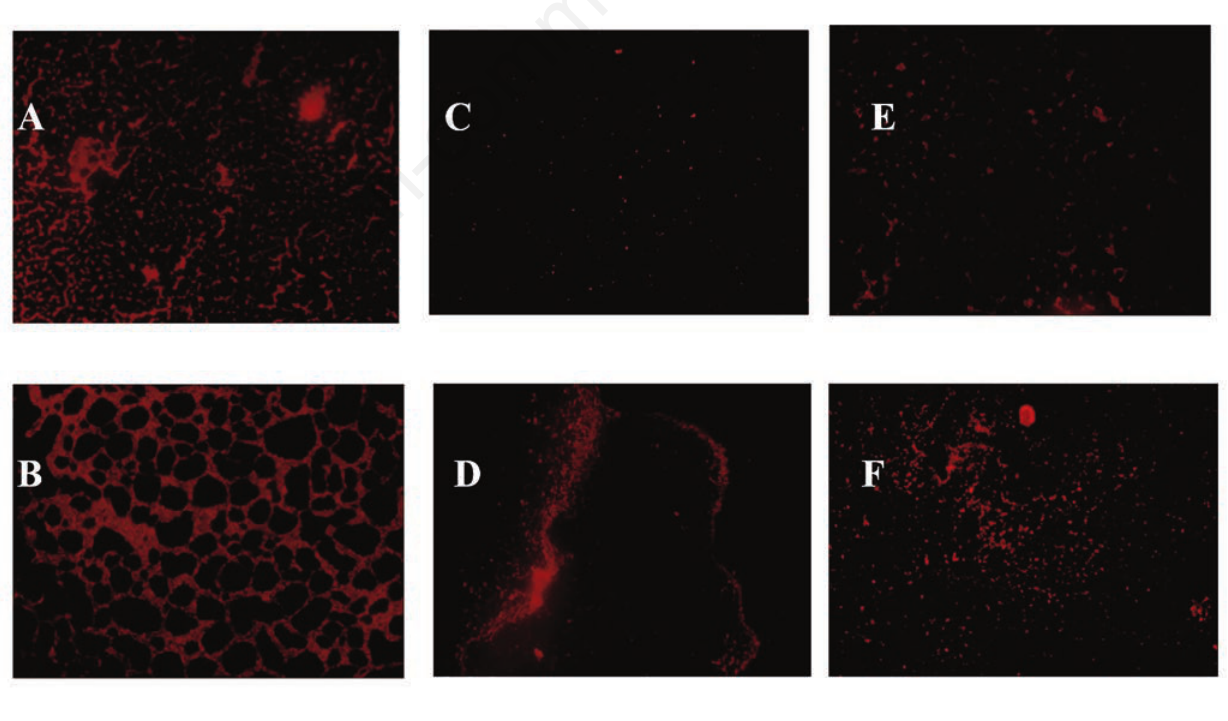
Figure 5. The results of fluorescence analysis at (a) 0 hour age biofilm control group (b) 0 hour age biofilm treatment group (c) 24 hour age biofilm control group (d) 24 hour age biofilm treatment group (e) 48 hour age biofilm control group (f) ) 48-hour-old biofilm treatment